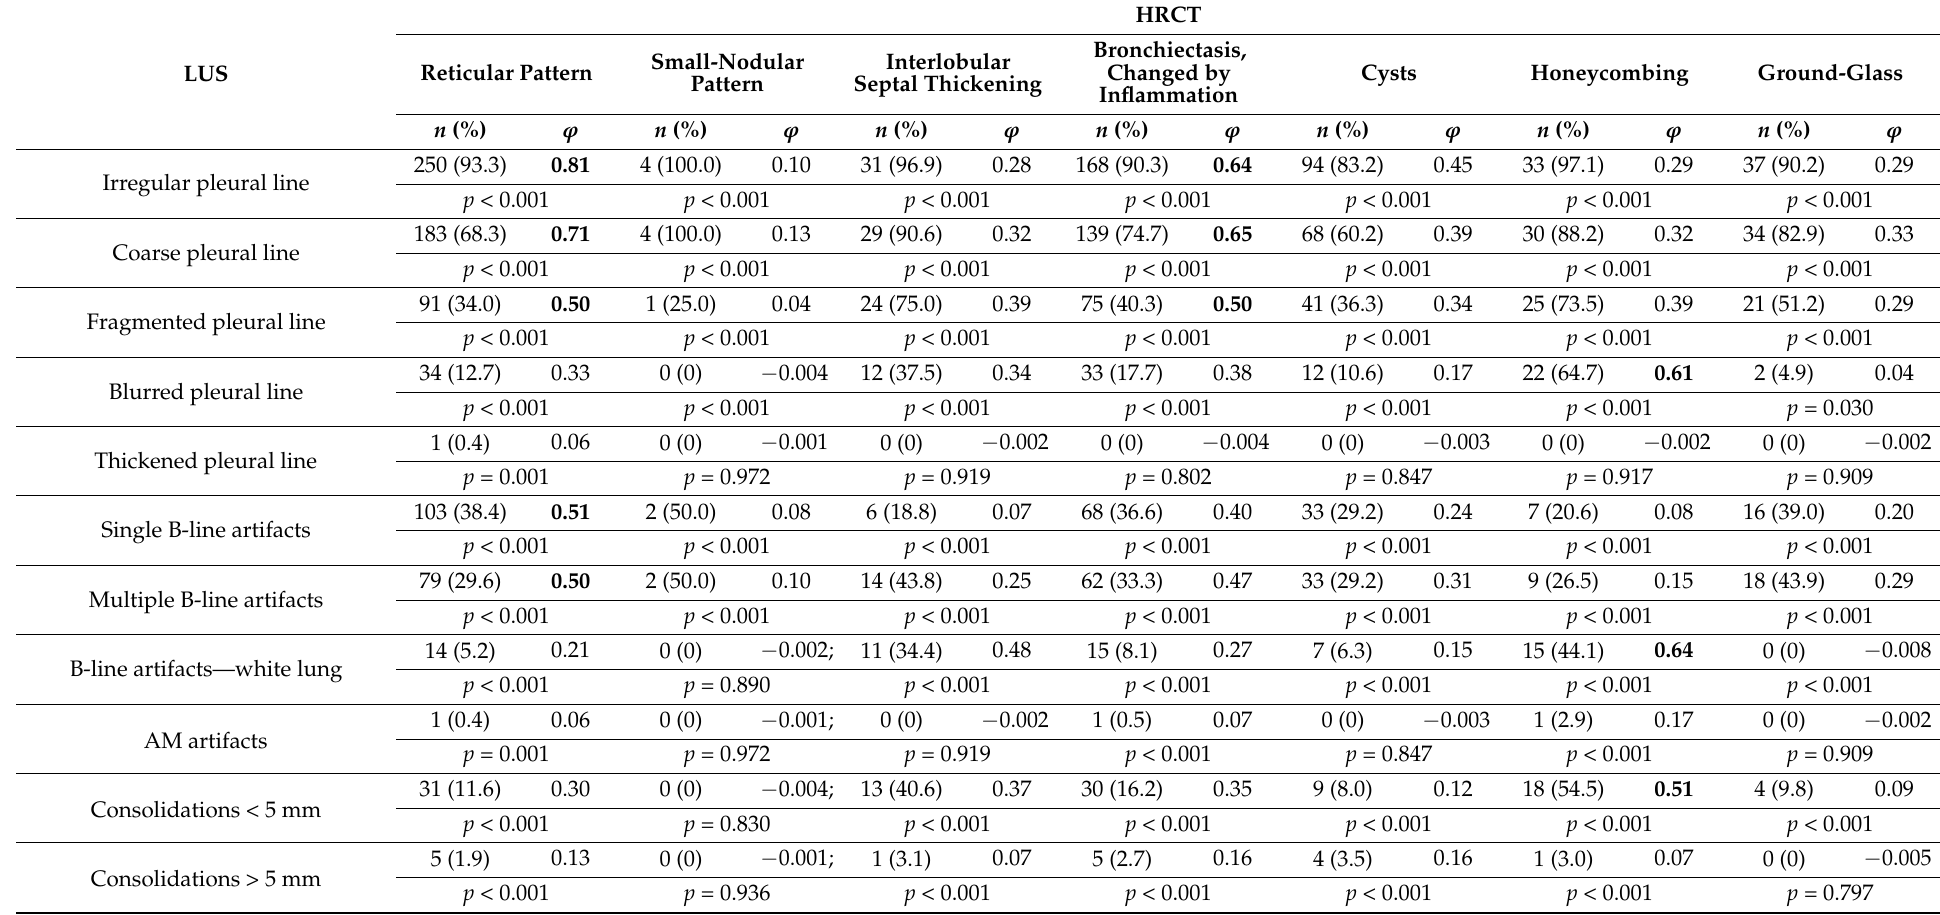
Table 5. Analysis of the frequency of findings with the coefficient ϕ for the correlations between findings detected in HRCT and LUS. Values marked by bold font indicate strong positive correlations. HRCT Bronchiectasis, Small-Nodular Interlobular Cysts Honeycombing Ground-Glass Reticular Pattern Changed by LUS Pattern Septal Thickening Inflammation